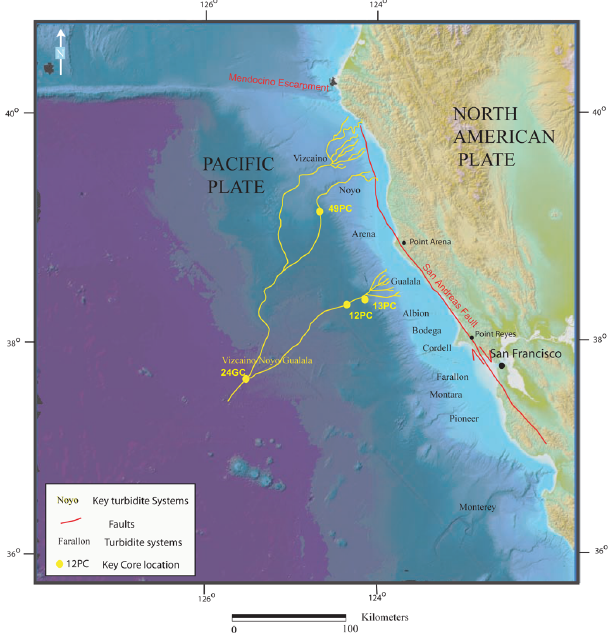
Fig. 2. Geological setting of the northern California active tectonic continental margin associated with the northern San Andreas Fault that is shown with a red line. Note location of key channels and the cores shown in Figs. 6 and 9. (Figure is modified from Guti´errez Pastor et al., 2012).